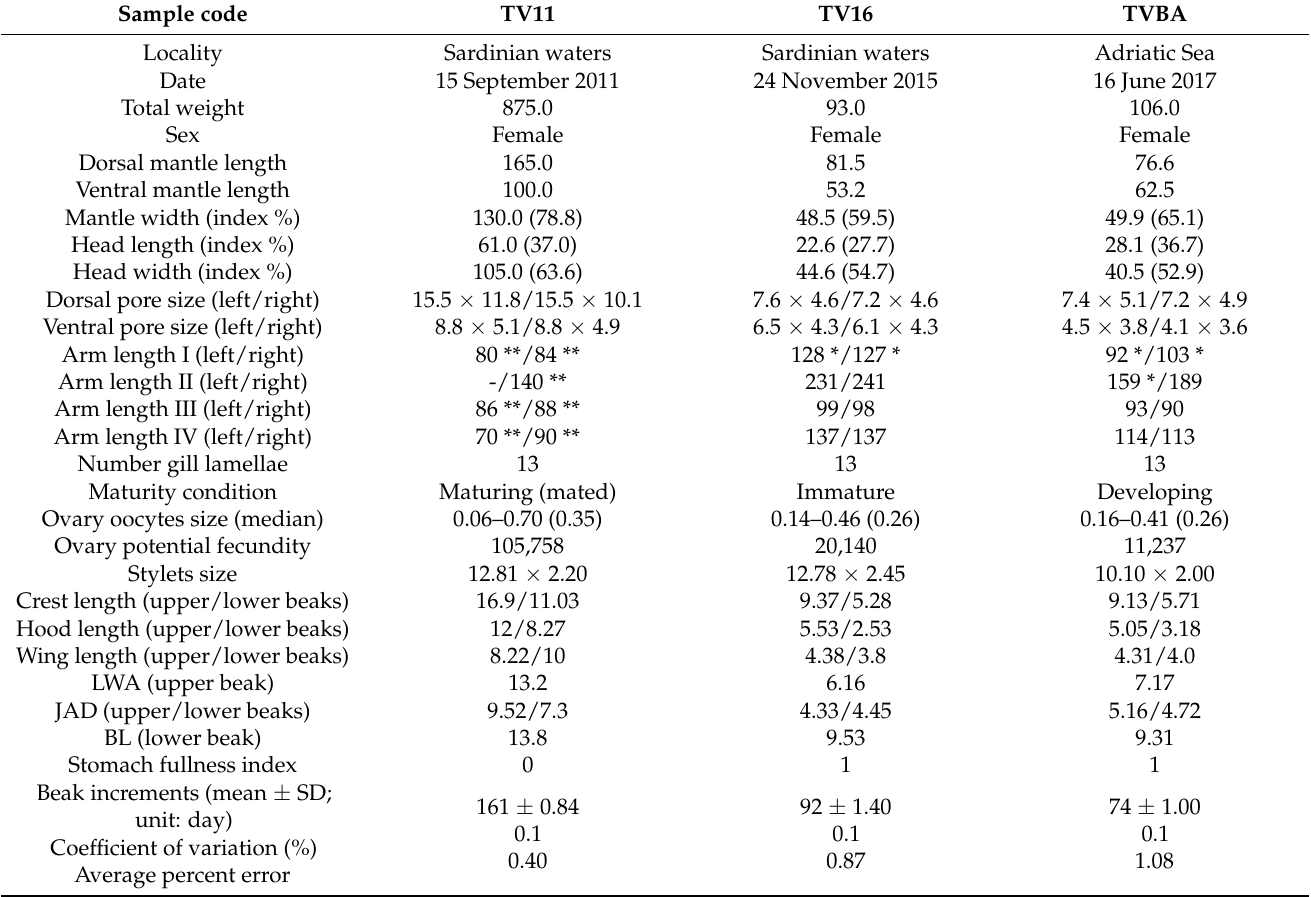
Table 1. Features of the three specimens of Tremoctopus violaceus caught in the Mediterranean